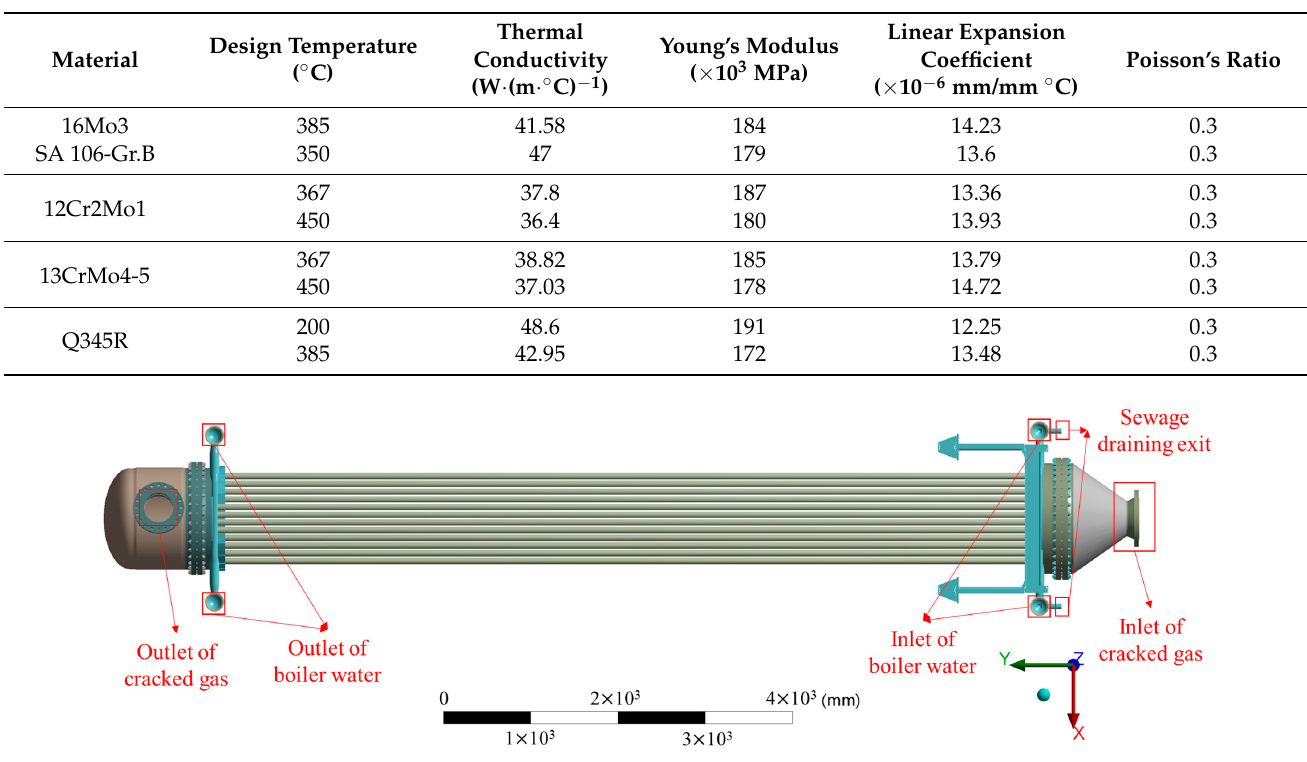
Figure 1. Whole geometric model of the quench boiler.